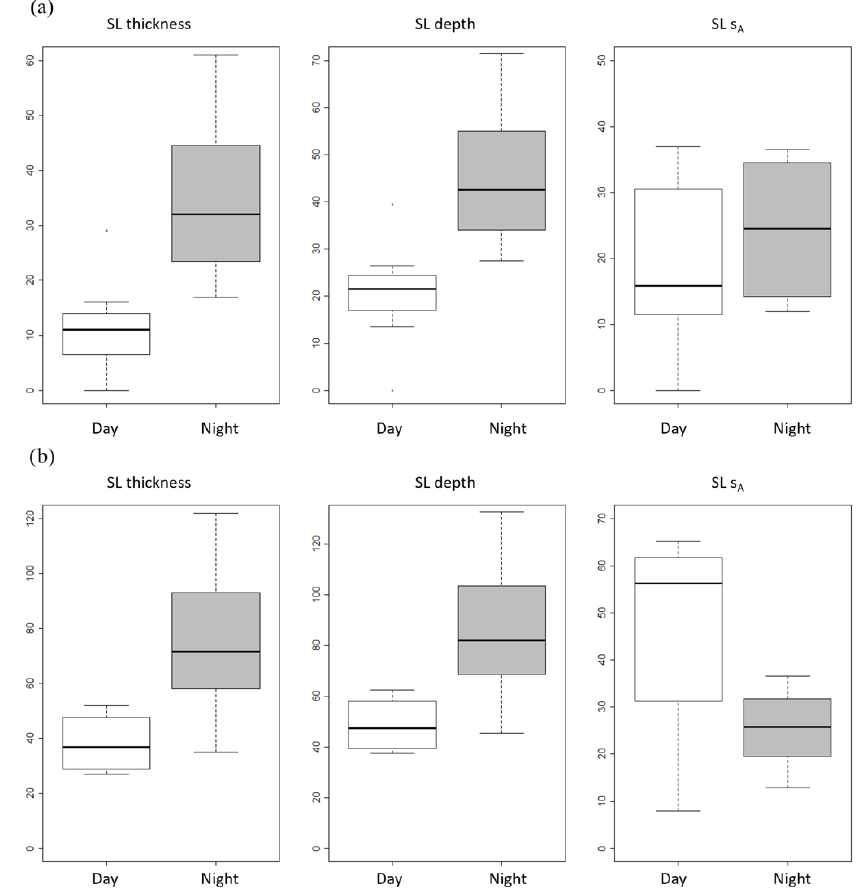
Figure 6. Box plot (minimum, maximum, and median) of sound-scattering layers (SSLs) mean depth (m), thickness (m), and relative biomass ( s A in m 2 nmi − 2 ) grouped by diel period (day and night) for (a) inshore area and (b) offshore area over the Senegalese continental shelf.